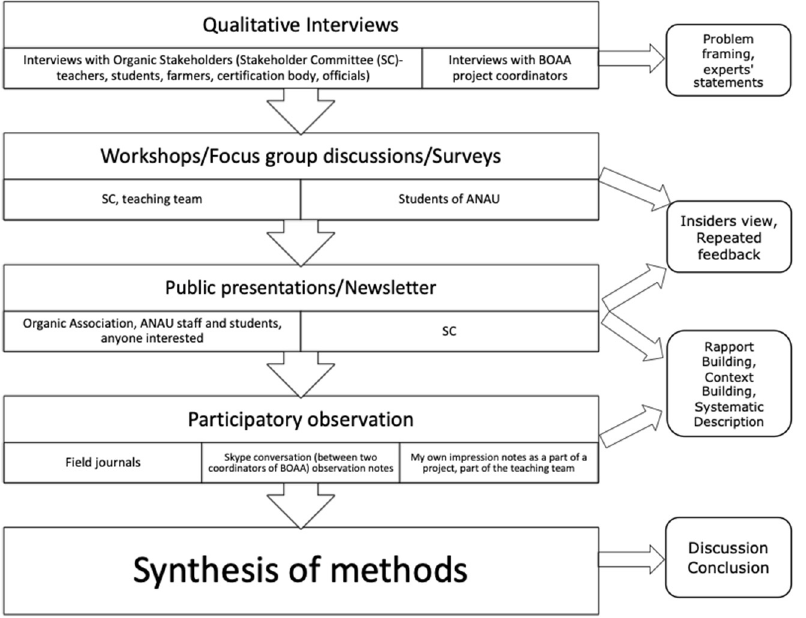
Figure 1. Methods, participants, and outcomes of participatory action research in curriculum devel- opment of the Organic Agriculture Master’s program.